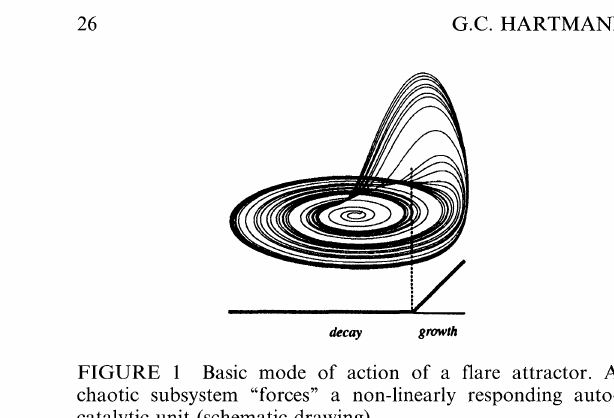
FIGURE Basic mode of action of a flare attractor. A chaotic subsystem "forces" a non-linearly responding auto- catalytic unit (schematic